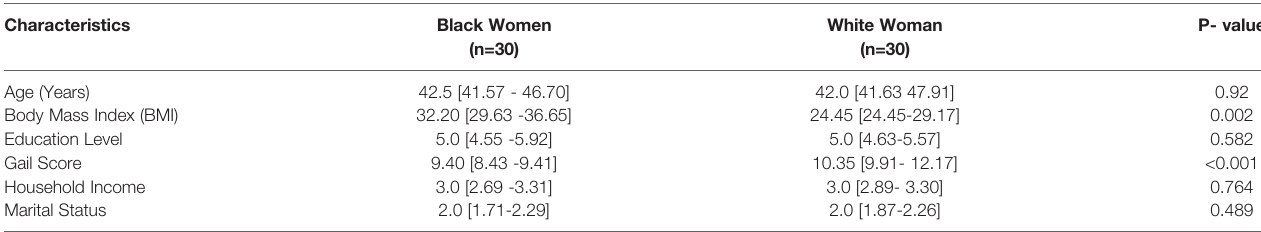
TABLE 1 | Patient cohort characteristics. Median and con fi dence intervals [CIs] for age.